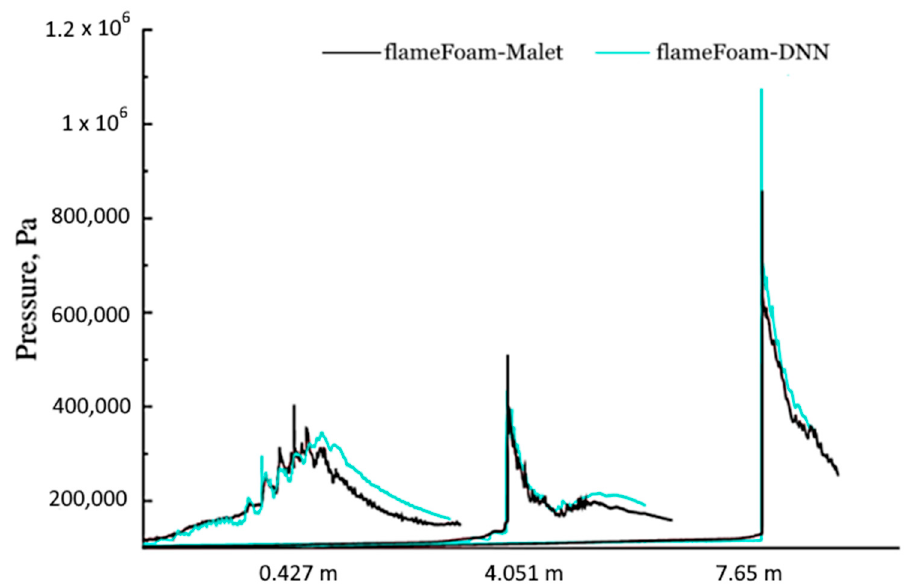
Figure 9. Pressure evolutions at different heights of ENACCEF2 (time-shifted).